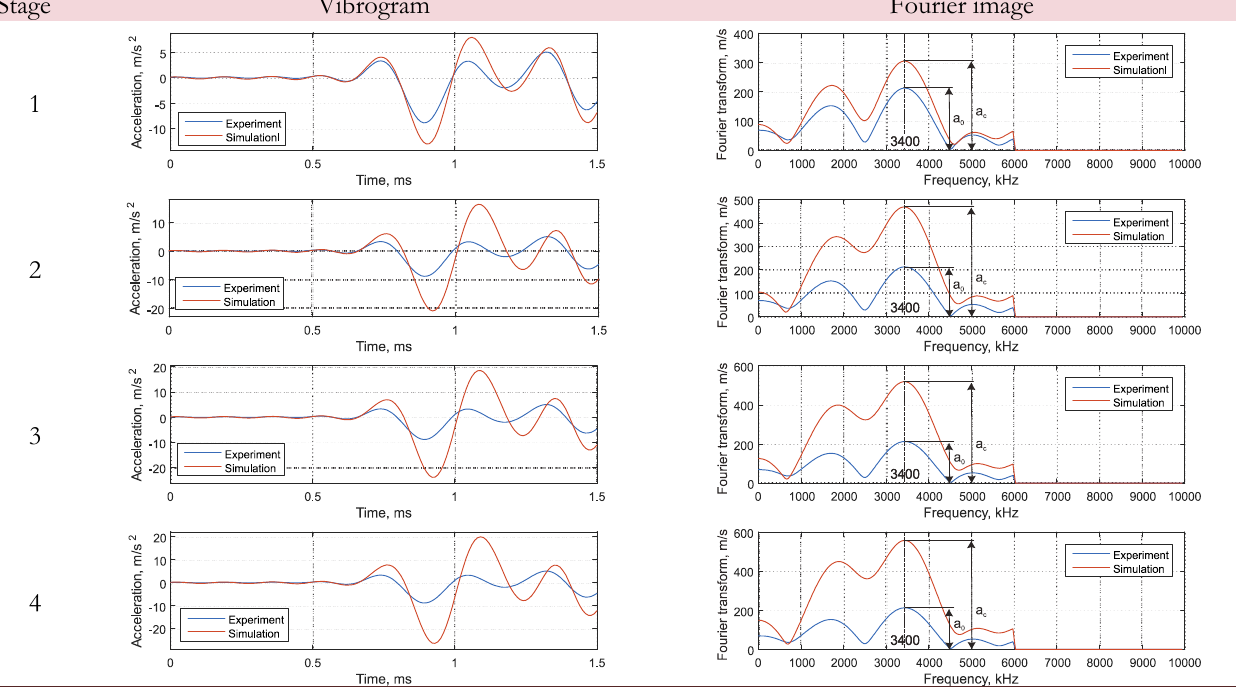
Figure 7: Changes in vibrograms at crack